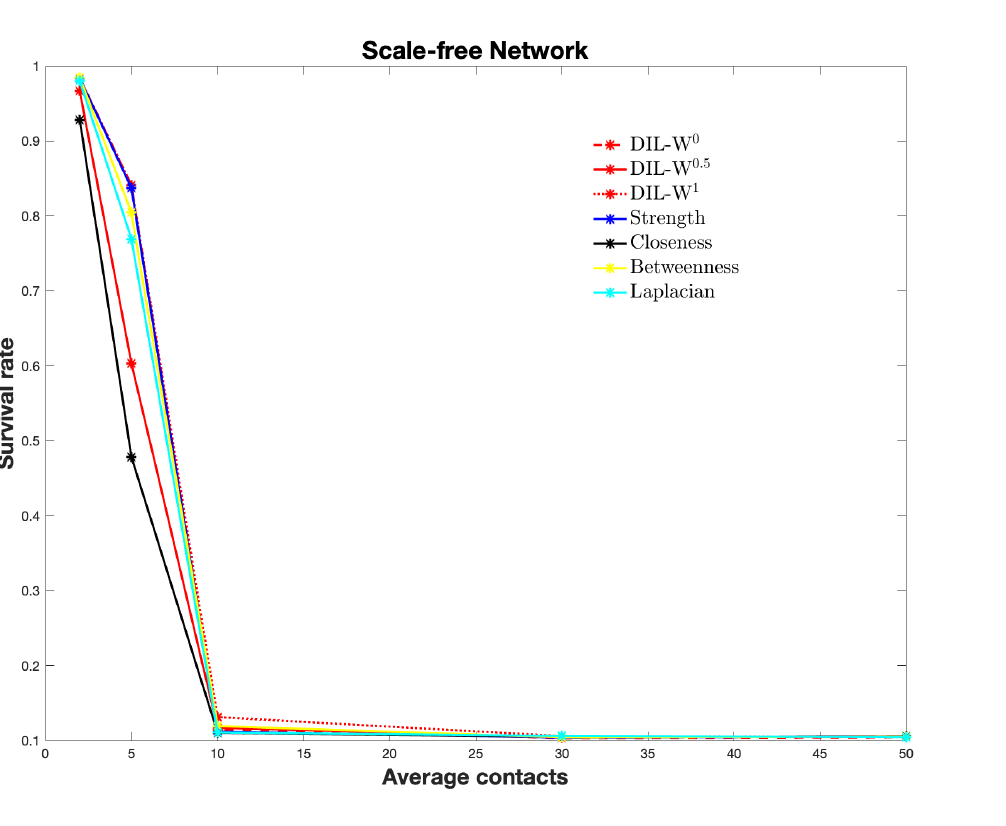
Figure 6. σ as a function of d on a Scale-free